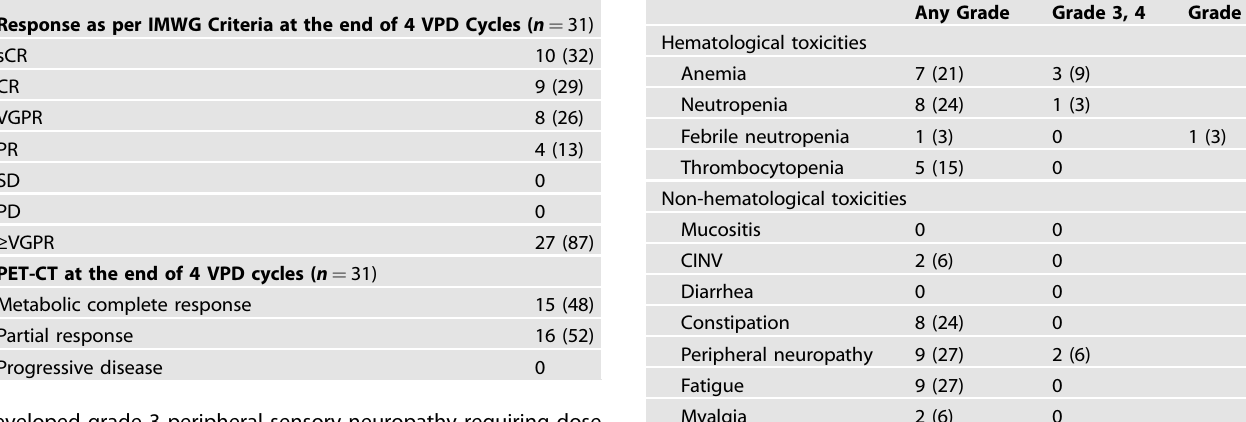
Table 3. Response assessment parameters of the study patients. Table 4. Adverse events of the study patients ( n =